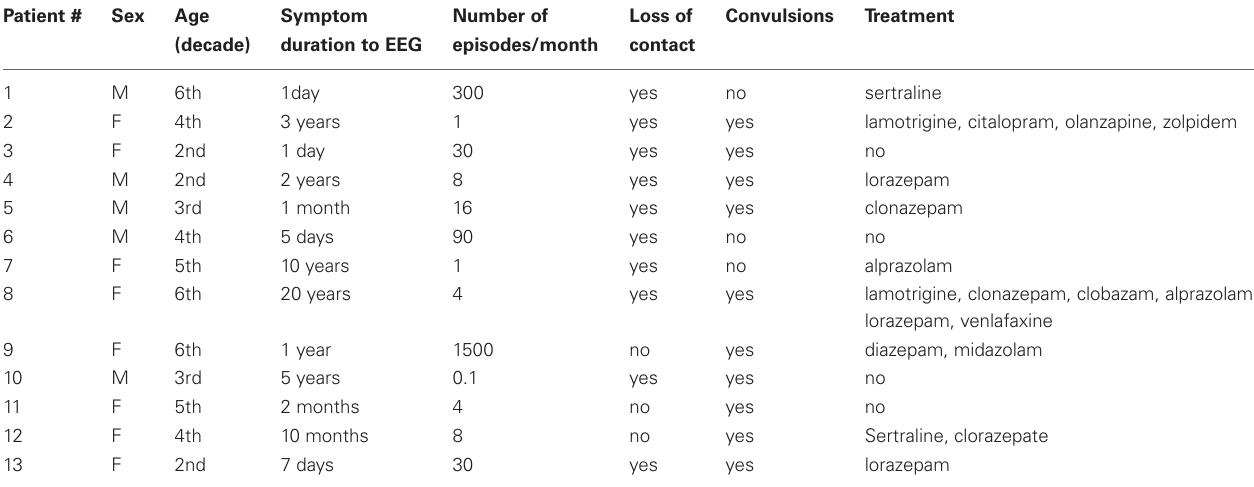
Table 1 | Clinical characteristics of PNES patients.